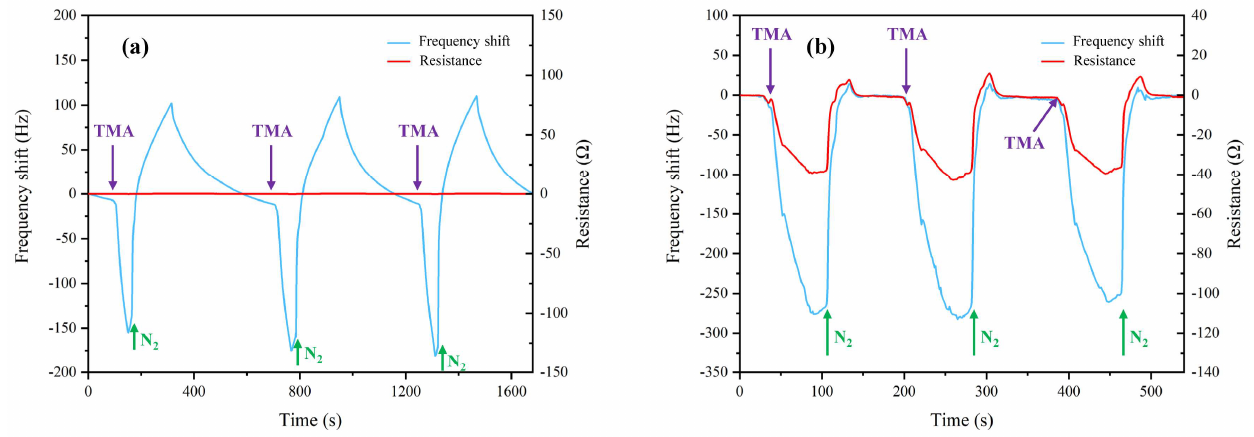
Figure 4. Sensing characteristics of QCM sensors to gas vapors. ( a ) The GO-based QCM sensor, and ( b ) the NGO-based QCM sensor.